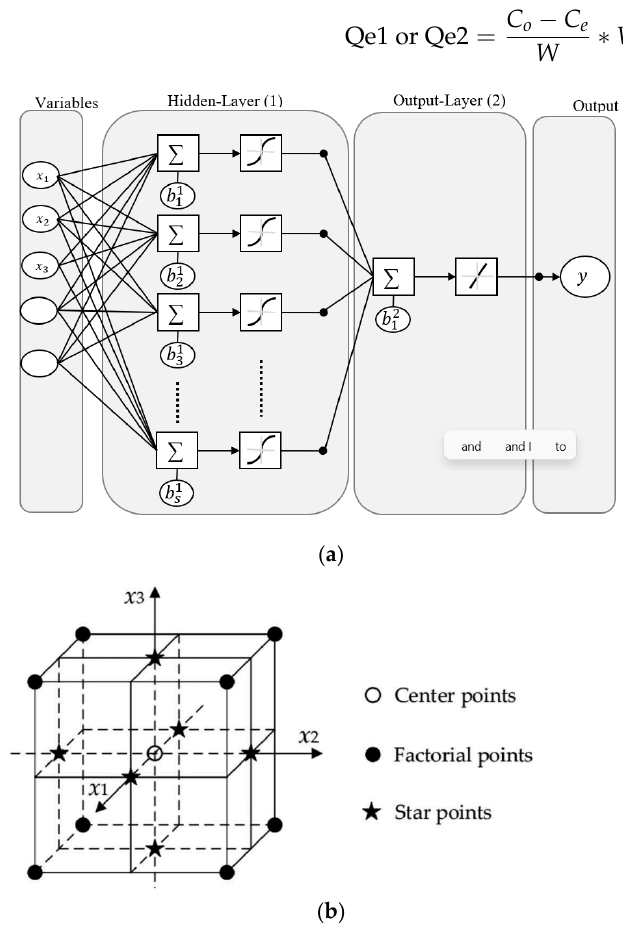
Figure 1. Schematic representation of ( a ) ANN and ( b ) 3-factor 3-level RSM-FC-CCD. Table 1. Cr(V) uptake for FC-CCD experimental design space. Experimental